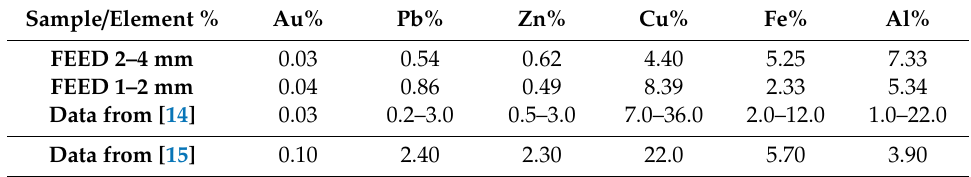
Table 1. Feed metal composition and some values reported in the literature.